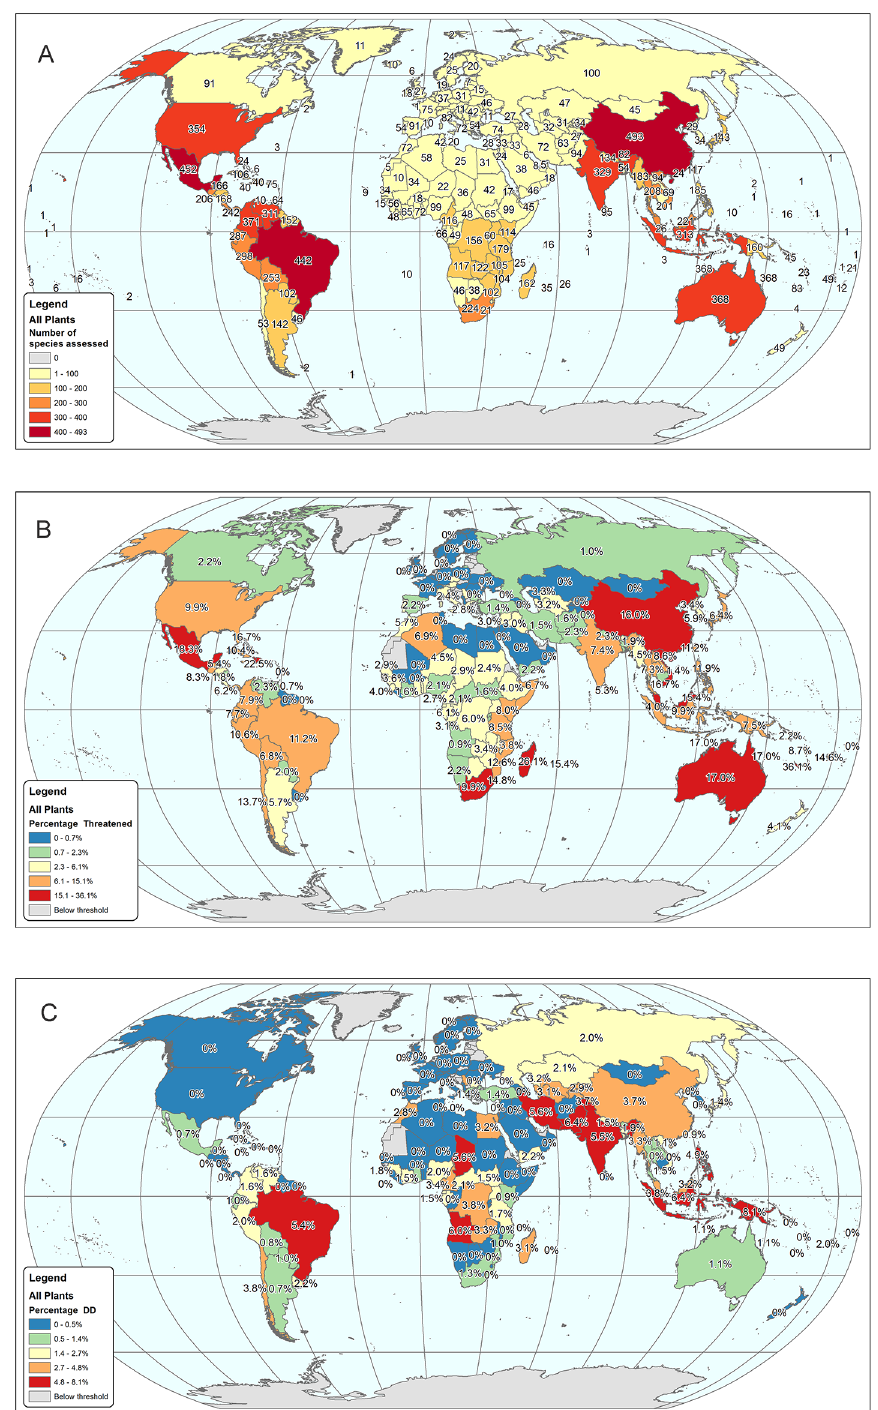
Fig 4. Global map of average extinction risk of species per country from the combined SRLI for Plants sample of gymnosperms, monocots, legumes and pteridophytes. A. Number of species assessed per country. B. Percentage of assessed species that are threatened per country. C. Percentage of assessed species that are Data Deficient per country.